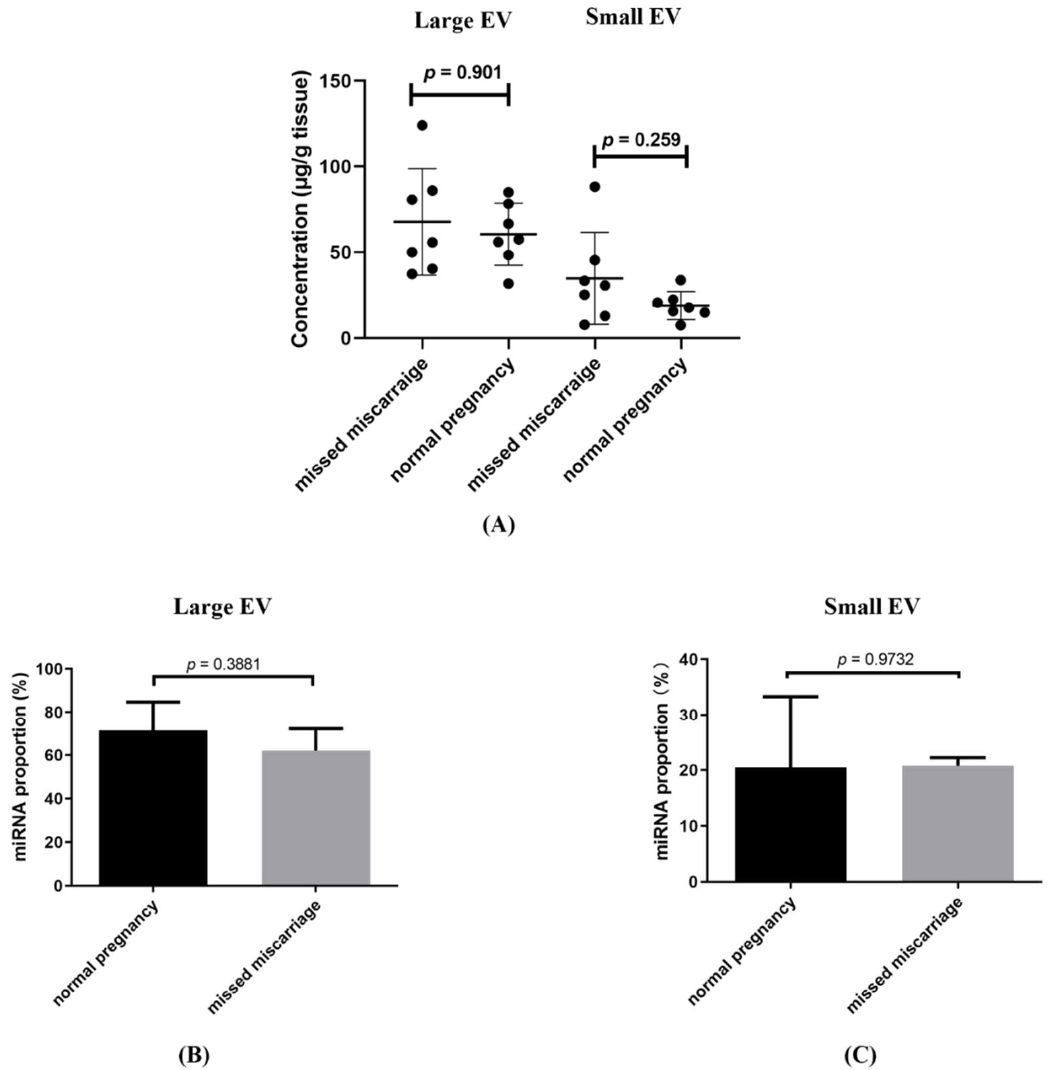
Figure 1. The concentration of total RNA associated with placental large and small EVs derived from healthy or missed miscarriage placentae ( A ), the proportion of miRNAs in non-coding RNAs in large EV ( B ) and small EVs ( C ) (data represents mean ± SD with seven repeats).